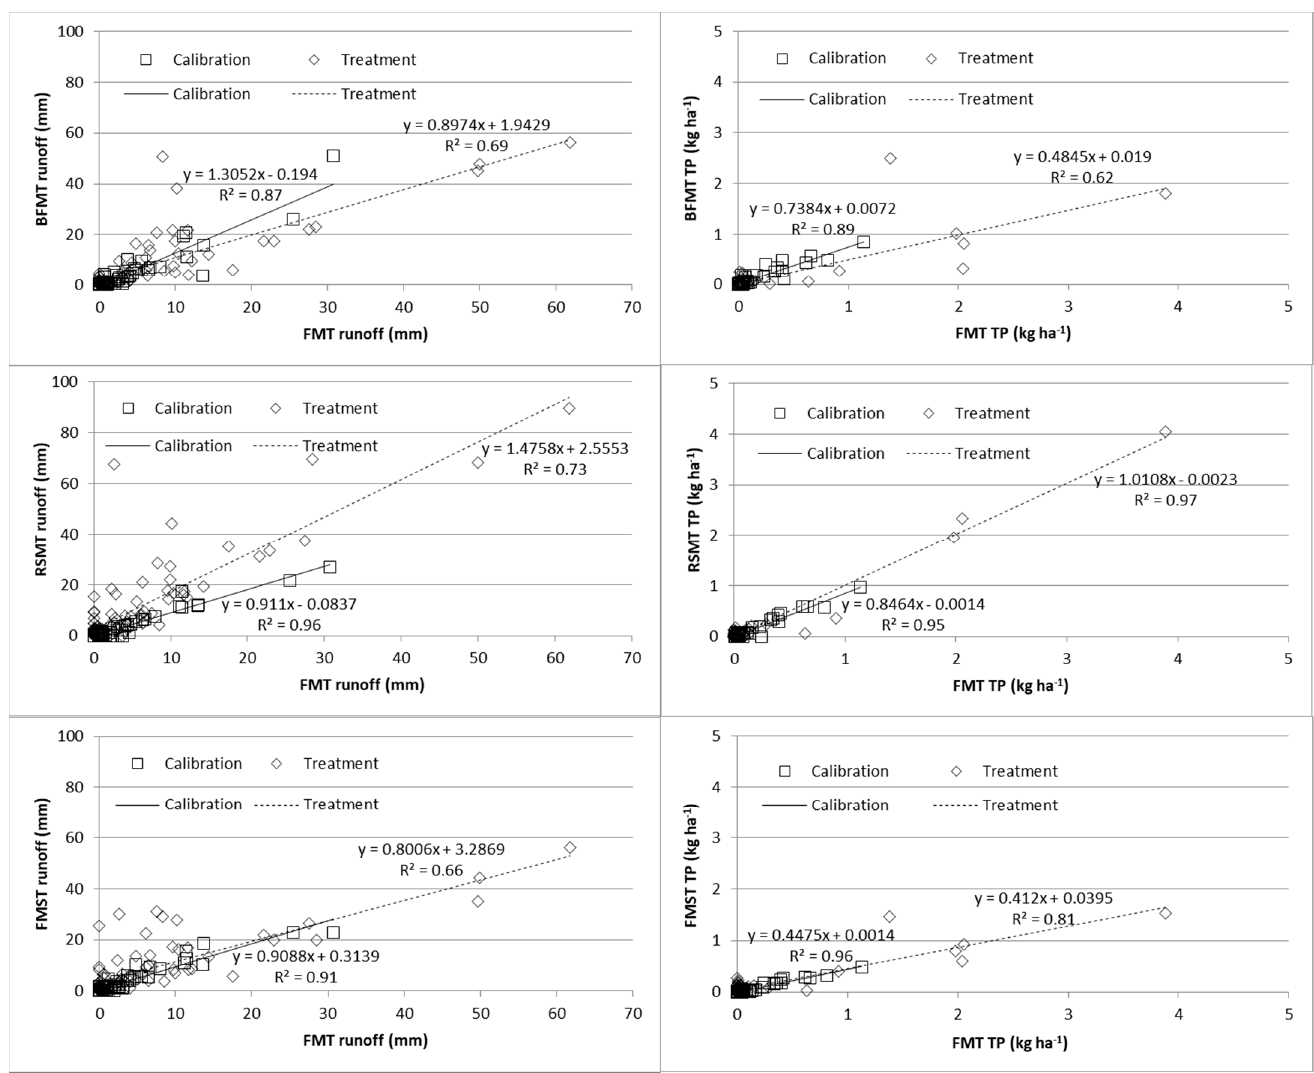
Figure 2. Relationships between each watershed (BFMT = fall applied manure/chisel tillage with grass buffer ( top ); RSMT = fall rye (cover crop) with spring-applied manure and chisel tillage ( center ); or FMST = fall applied manure with spring tillage ( bottom ) and FMT (fall applied manure with chisel tillage) during the calibration and treatment period for runoff quantity (mm) ( left ) and total P (TP) load (kg ha − 1 ) ( right ). The solid and dashed lines are linear regressions for the calibration and treatment periods, respectively.